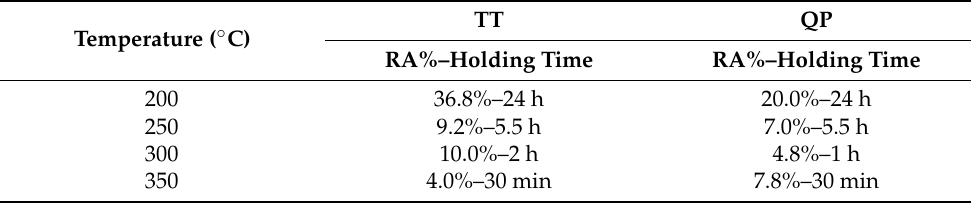
Table 2. RA phase fraction of TT and QP conditions.